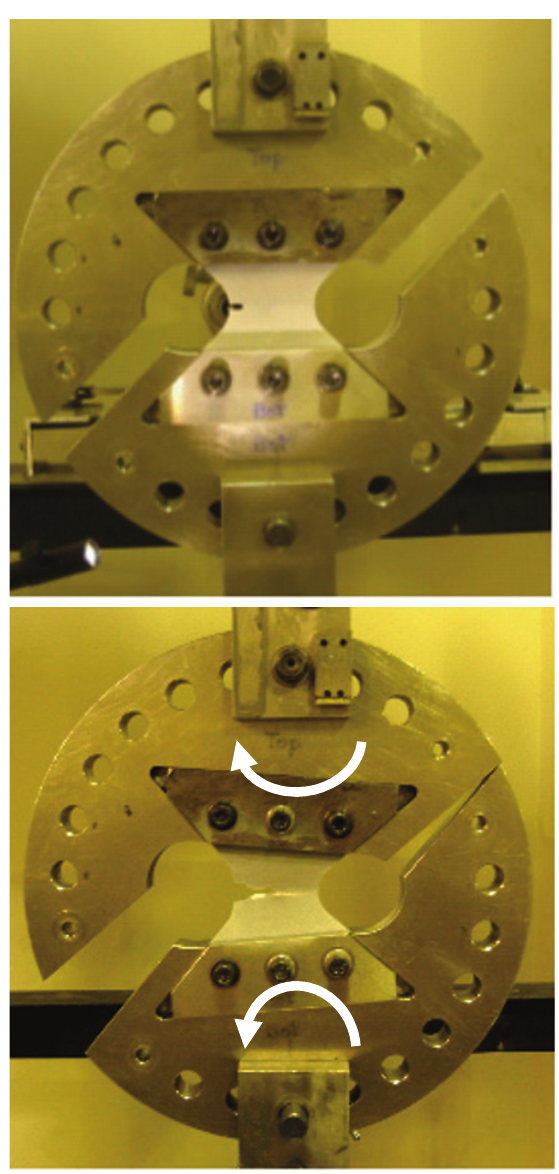
Figure 2. The fixture rotation during the loading in mode